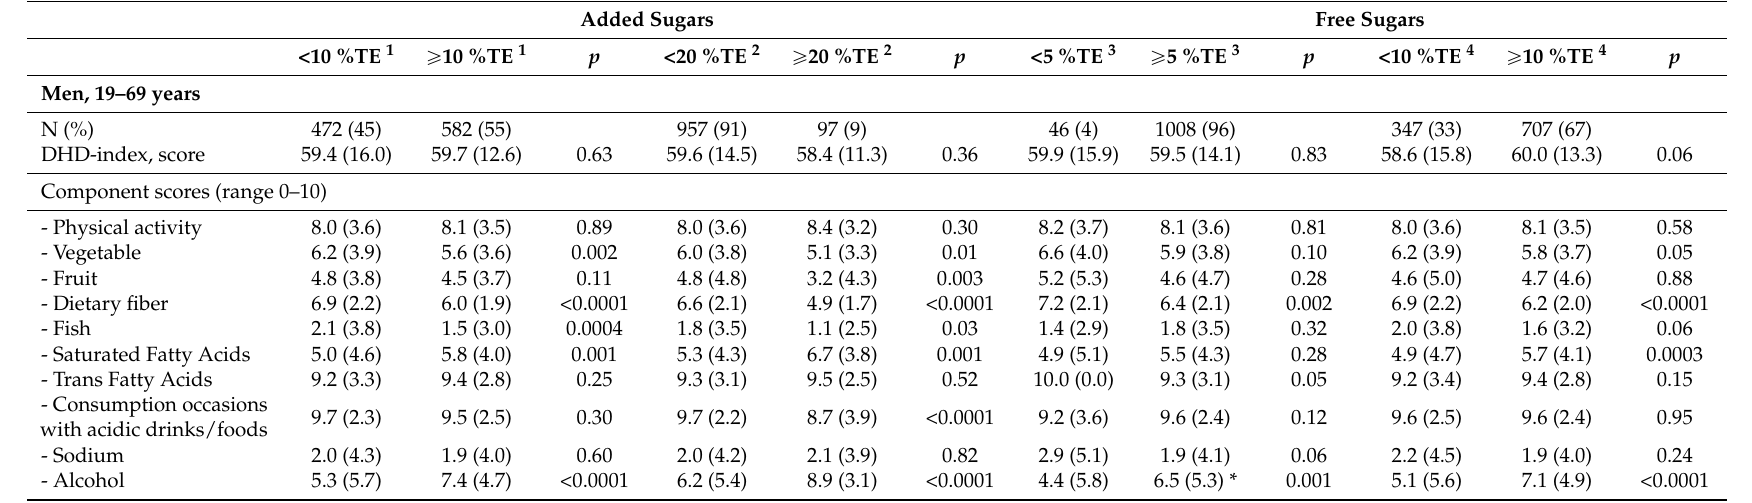
Table 4. Adherence to guidelines of added and free sugars and diet quality as measured with the Dutch Healthy Diet-index (mean (SD)) in 1054 adult men and 1050 adult women from the Dutch National Food Consumption Survey